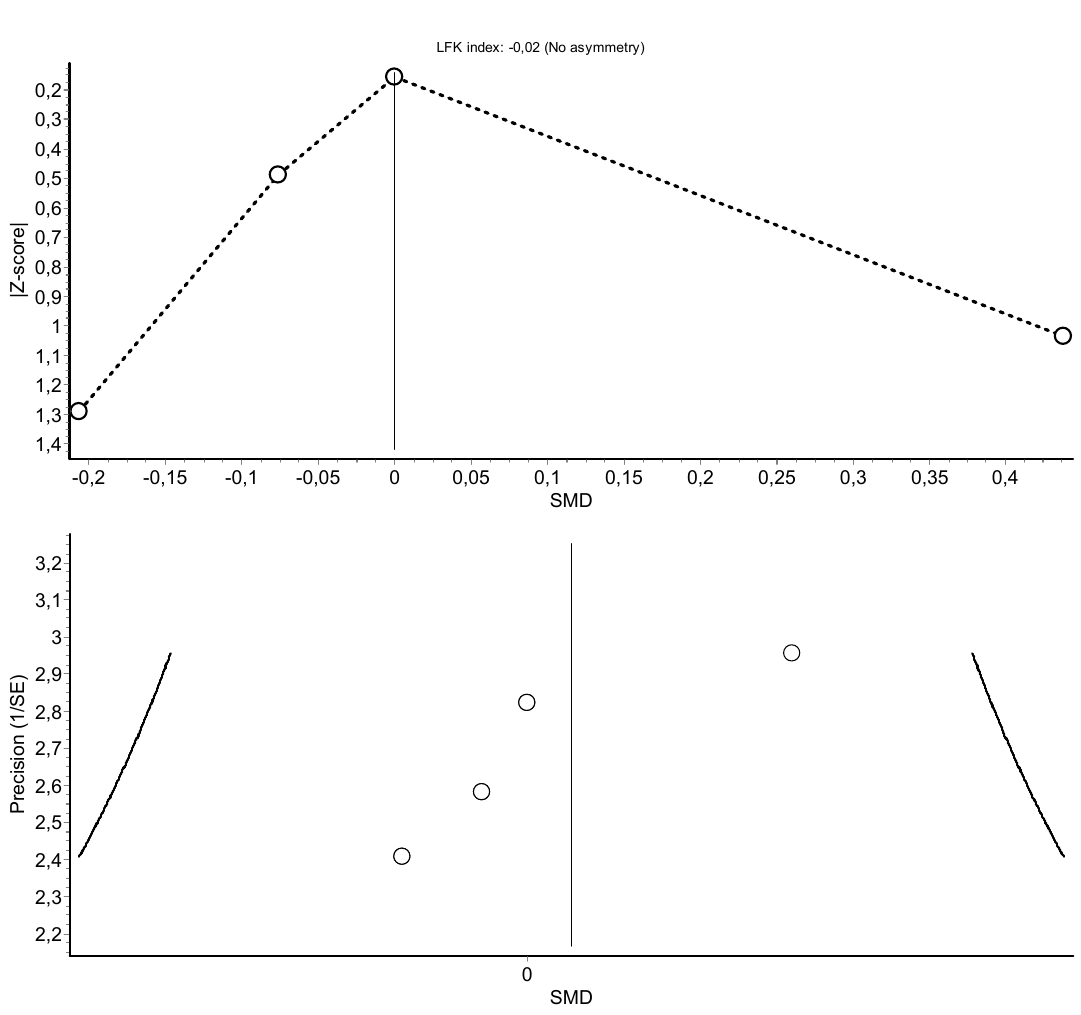
Figure A6. Synthesis forest plot of body weight. Negative favor HIIT intervention. The forest plot summarizes the results of included studies (standardized mean differences [SMDs] and weight). The small boxes with the squares represent the point estimate of the effect size and sample size. The lines on either side of the box represent a 95% confidence interval (CI).